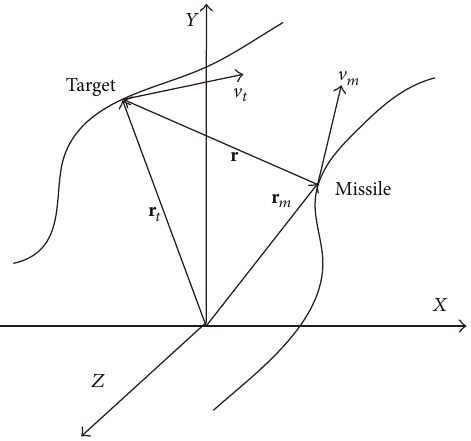
Figure 1: Missile-target engagement